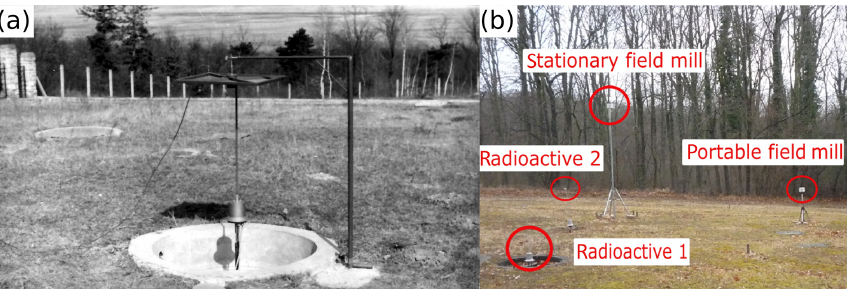
Figure 4. (a) The oldest radioactive collector, installed in 1961, during calibration in the early days. (Re-printed from Wesztergom, 2007.) (b) Currently operating PG instruments at NCK. Radioactive 1 represents the older, radioactive collector (shown in a ), whereas radioactive 2 is the more novel radioactive equipment installed in 1998.